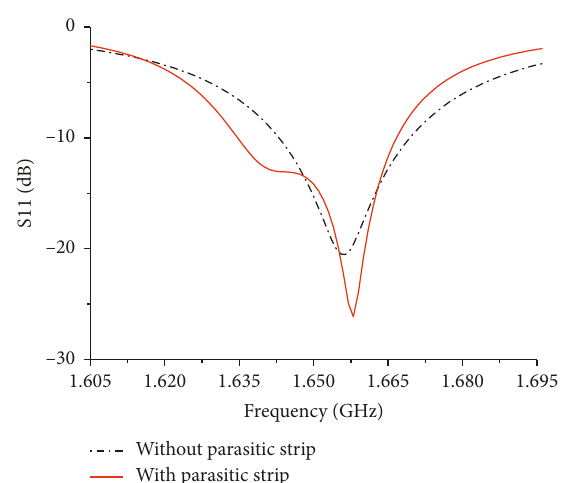
Figure 8: The antenna S11 with and without the C-shaped parasitic strip.